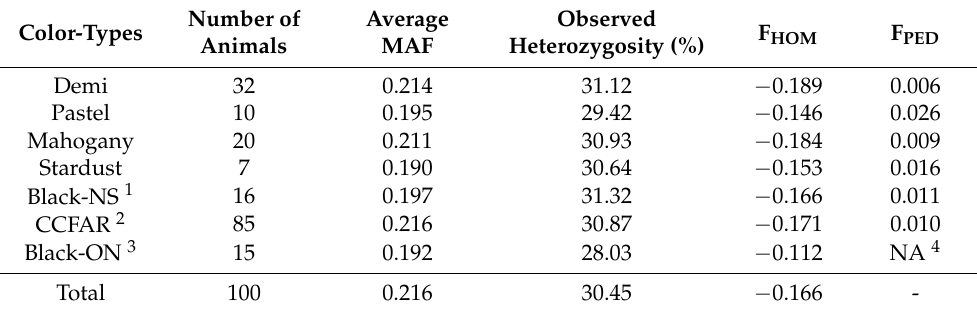
Table 1. Average minor allele frequency (MAF), observed heterozygosity, inbreeding rates based on excess of homozygosity (F HOM ) and pedigree (F PED ) for five color-types of American mink using whole genome sequence data.